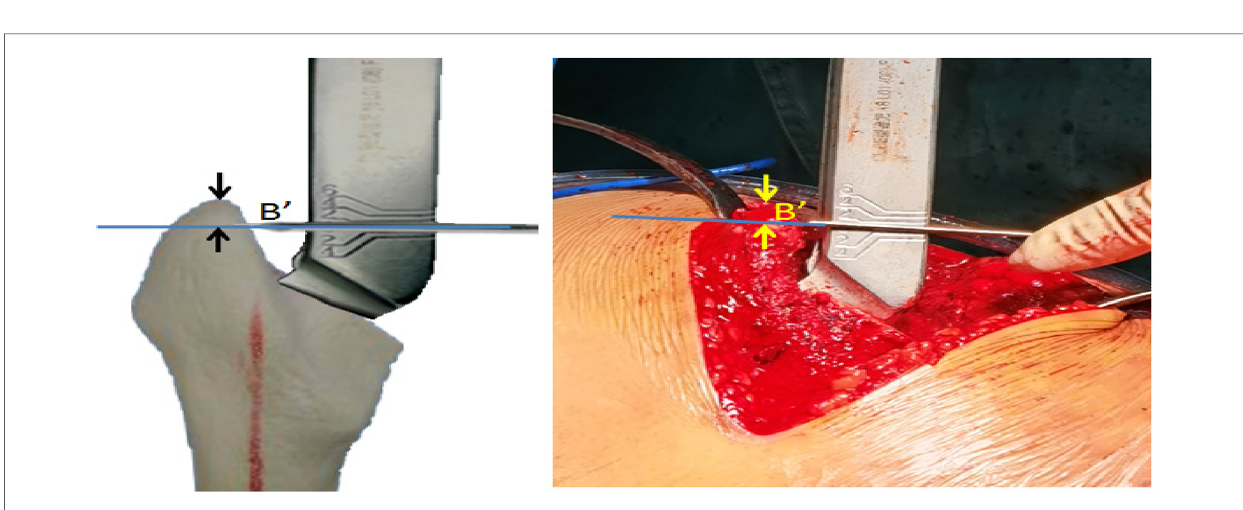
FIGURE 3 Intraoperative measurement of the height of femoral head B ’